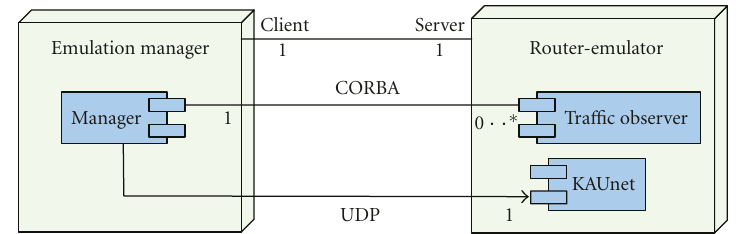
Figure 11: W-NINE deployment diagram.